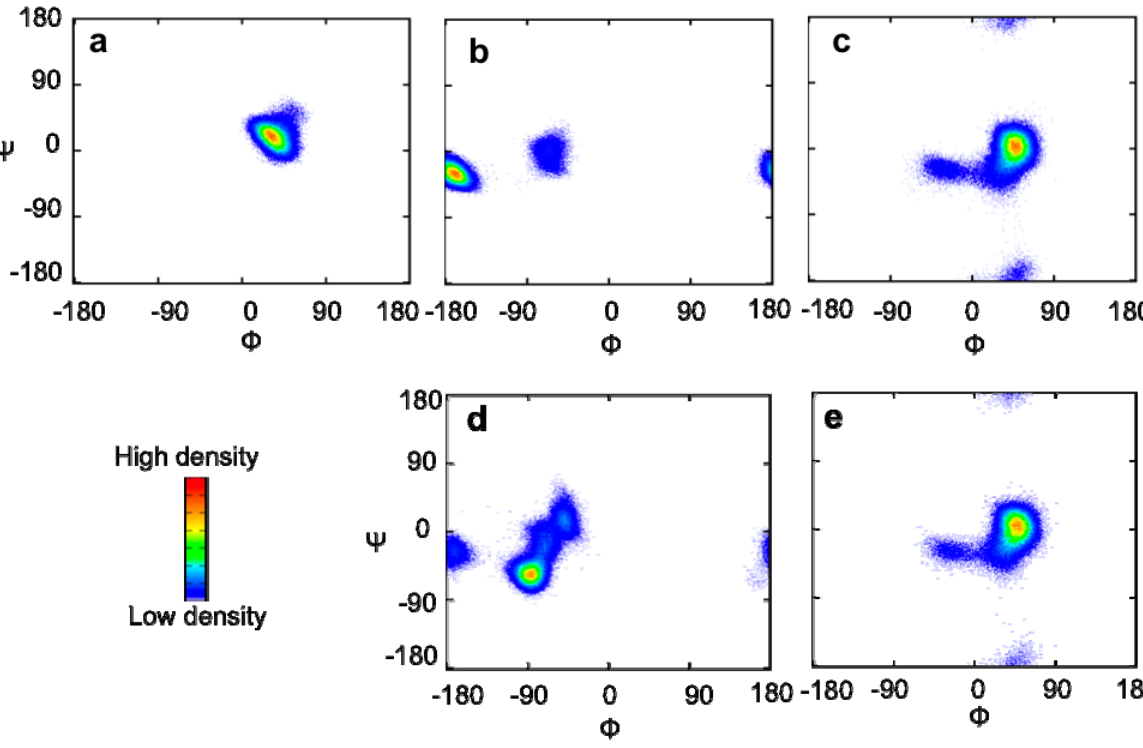
Figure 1. Torsion angle density maps of the combined MD trajectory of ( a , b , and c ) GM2 tetrasaccahride and ( d and e ) GM3 trisaccahride [13]. ( a ) The GalNAc–Gal, ( b and d ) the Neu5Ac-Gal, and ( c and e ) the Gal-Glc linkages. The d and e parts of this figure were reproduced by permission of The Royal Society of Chemistry. The definitions of Φ and